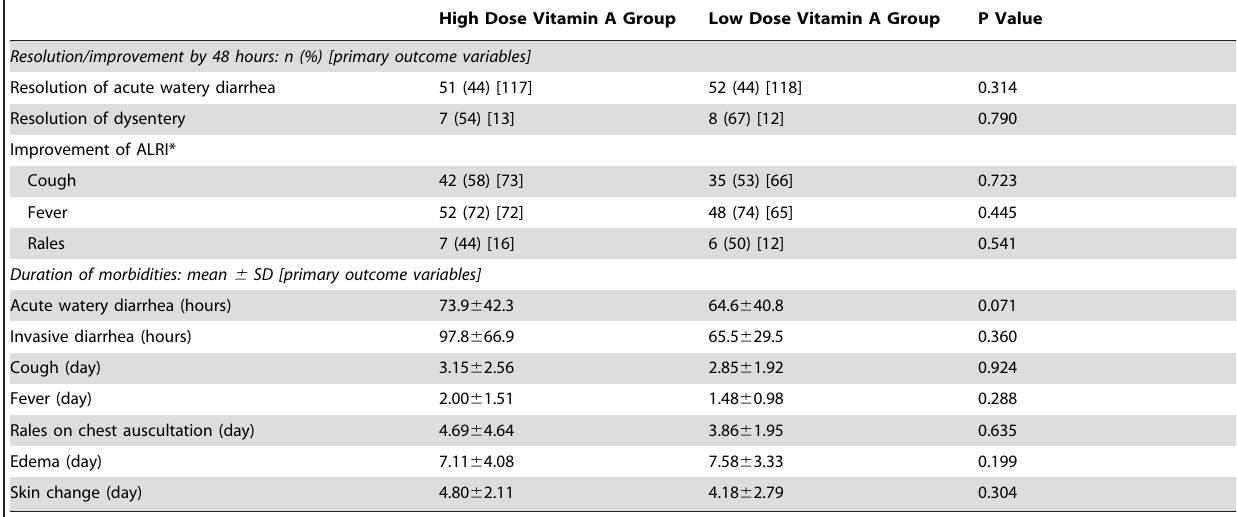
Table 2. Resolution of morbidities by treatment group.